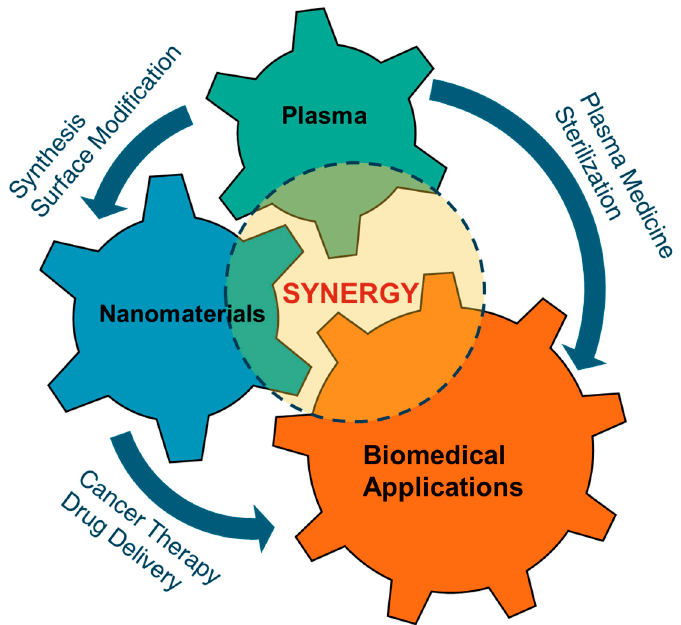
Figure 1. The synergistic relationship among plasmas, nanomaterials and their biomedical applications.